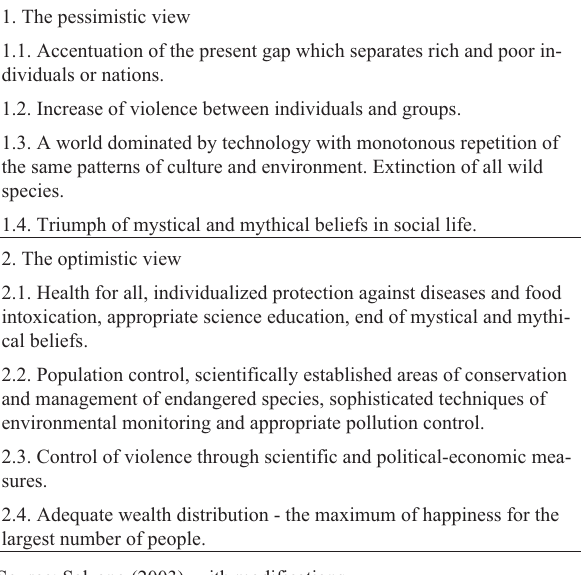
Table 5 - Two contrasting views about mankind’s